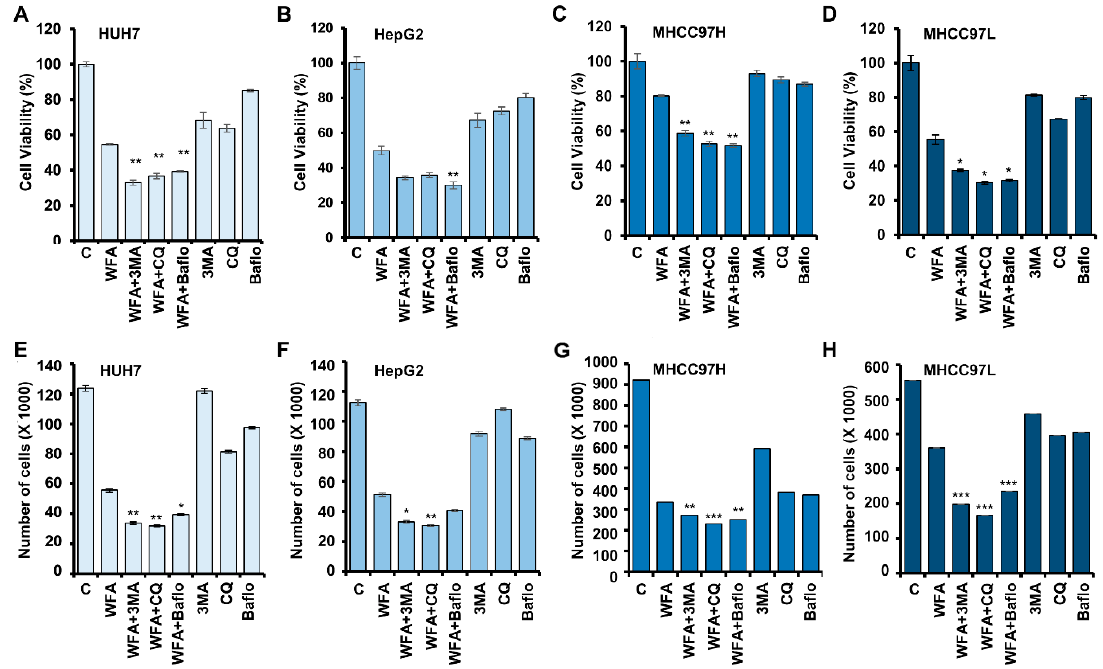
Figure 6. Withaferin A-mediated autophagy in HCC cells is cytoprotective in nature. ( A – D ) Cell viability of various HCC cells after treatment with 5 µM WFA alone and in combination with 4 mM of 3MA (3-Methyl adenine), 25 µM CQ or 200 nM bafilomycin, respectively. ( E – H ) HCC cells were treated with 5 µM WFA alone and in combination with 4 mM 3MA, 25 µM CQ and 200 nM bafilomycin, respectively, and subjected to trypan blue dye exclusion assay. * p < 0.05, compared with Withaferin A; ** p < 0.01, compared with WFA; *** p < 0.001, compared with Withaferin A.